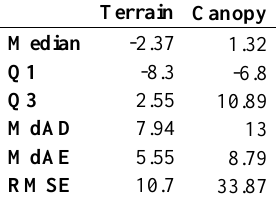
Overall accuracy metrics (m) of GEDI-ALS height